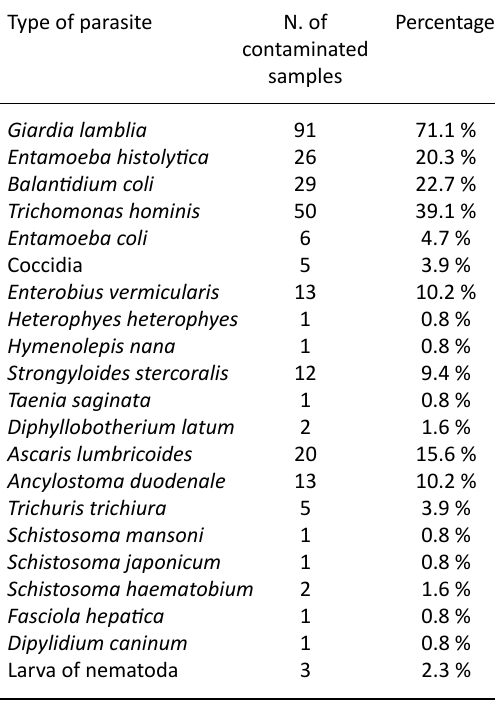
Table 1. Distribution of detected parasites in the examined fresh vegetables Type of parasite N. of